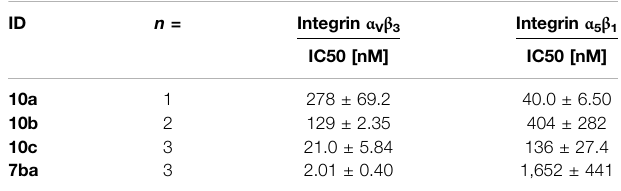
TABLE5| ResultsoftheELISA-likeassayfortheconjugableRGDmimetics10a-c ( Figure 9